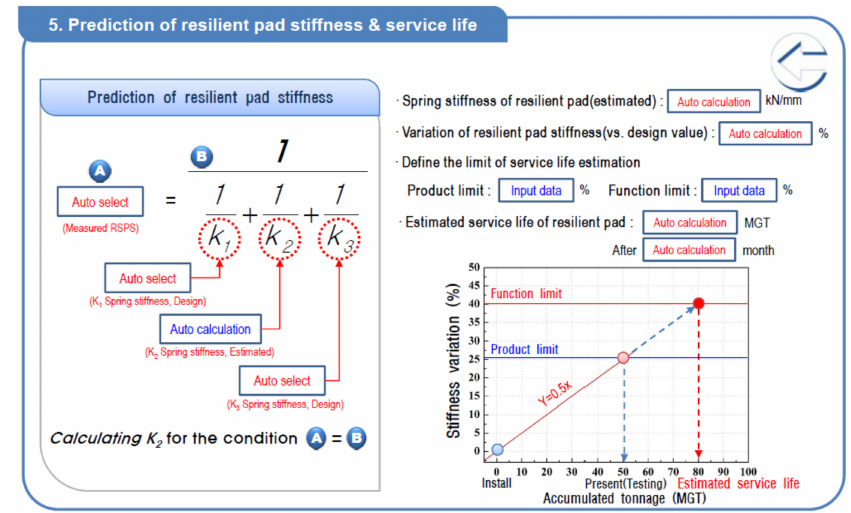
Figure 11. Evaluation of track support sti ff